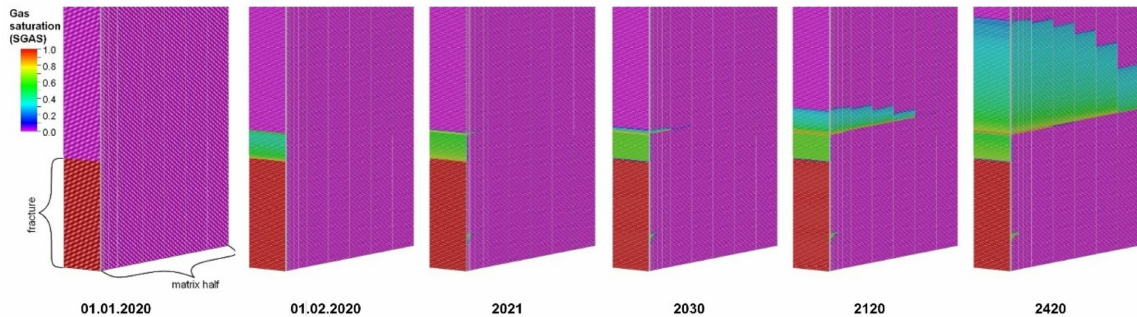
Figure 26. CO 2 migration in the fracture and pores of the overburden rocks. Distribution of CO 2 saturation as a function of time. Model I, Sub-scenario